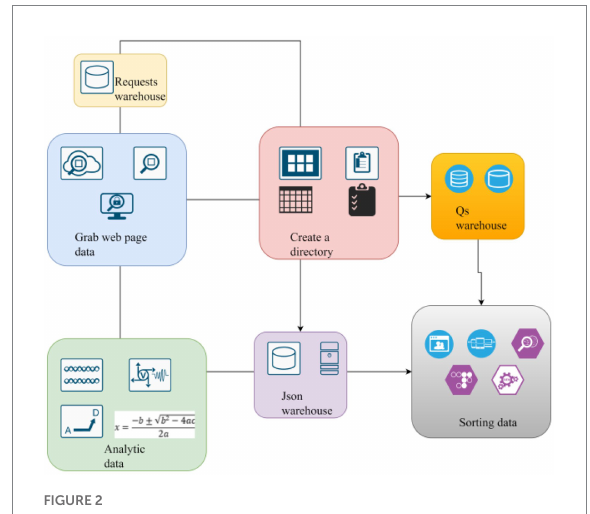
FIGURE 2 The data crawling flow chart.